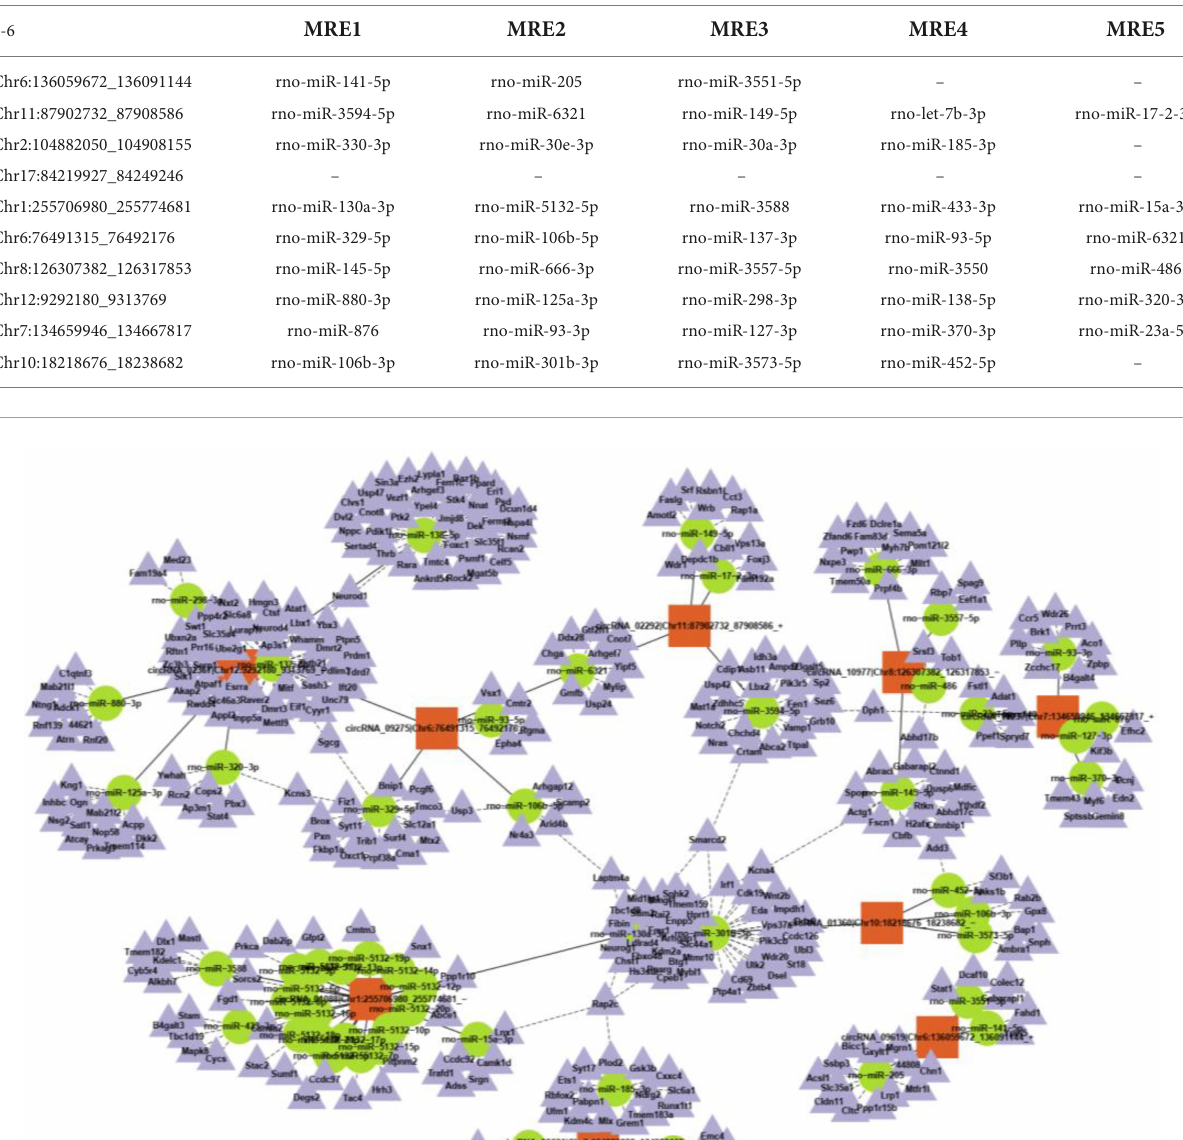
TABLE 2 Predicted miRNA response elements of the ten typical differentially expressed circRNAs. CircRNA ID